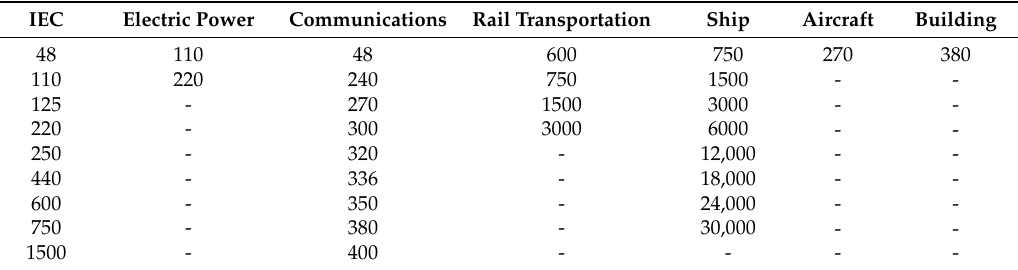
Table 1. Voltage levels of medium and low voltage (V) DC power supply system.